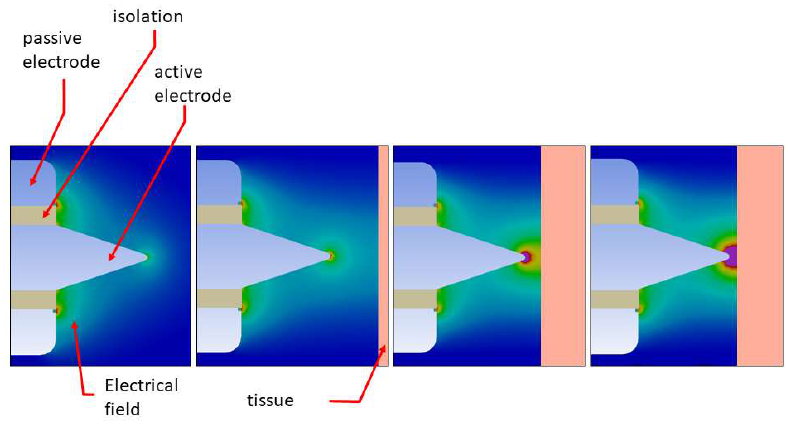
Figure 1. Inhomogeneous electric field, high voltage, and electric arc.